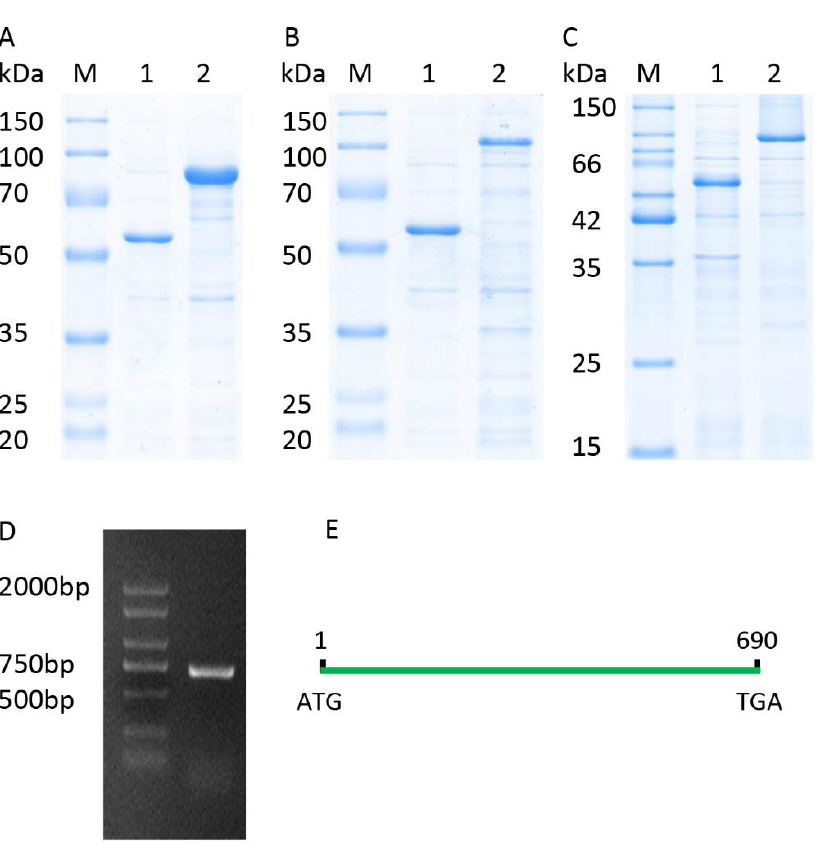
Figure 3. Recombinant expression analysis and full-length CDS of TaICK1. ( A ) Lane M: protein